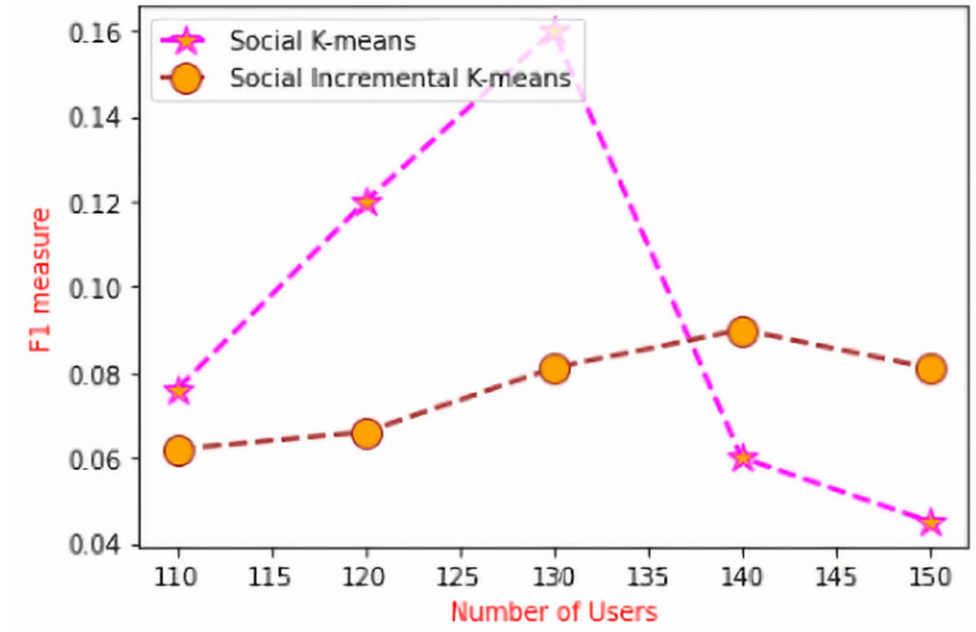
Figure 11. F1 measure—K-means versus incremental K-means algorithms with social